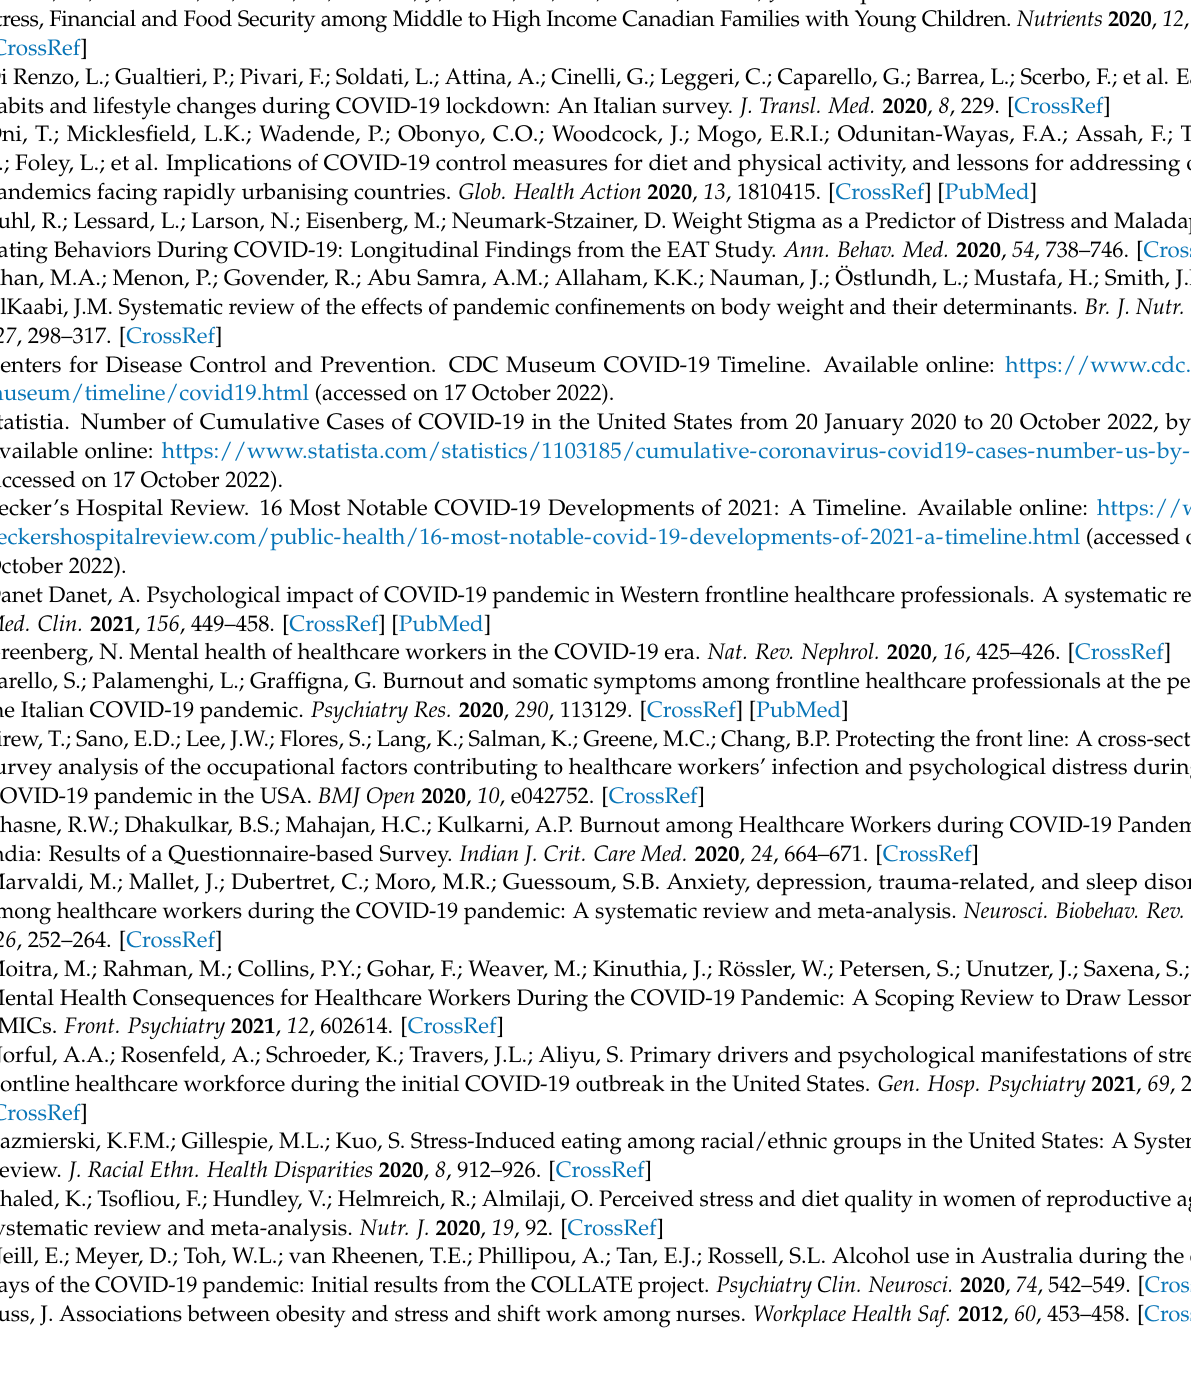
Table A2. Cont. 1. Higher CHAMPS parent PHQ2 levels are associated with lower PA levels, but CHAMPS parent PHQ2 levels did not predict how PA levels change over time. Psychological Factors at 2. No evidence of a relationship between GAD7 and PA levels. CHAMPS Parent and PA 3. Higher CHAMPS parent ISI levels are associated with lower PA levels, but CHAMPS parent ISI levels did not predict how PA levels change over